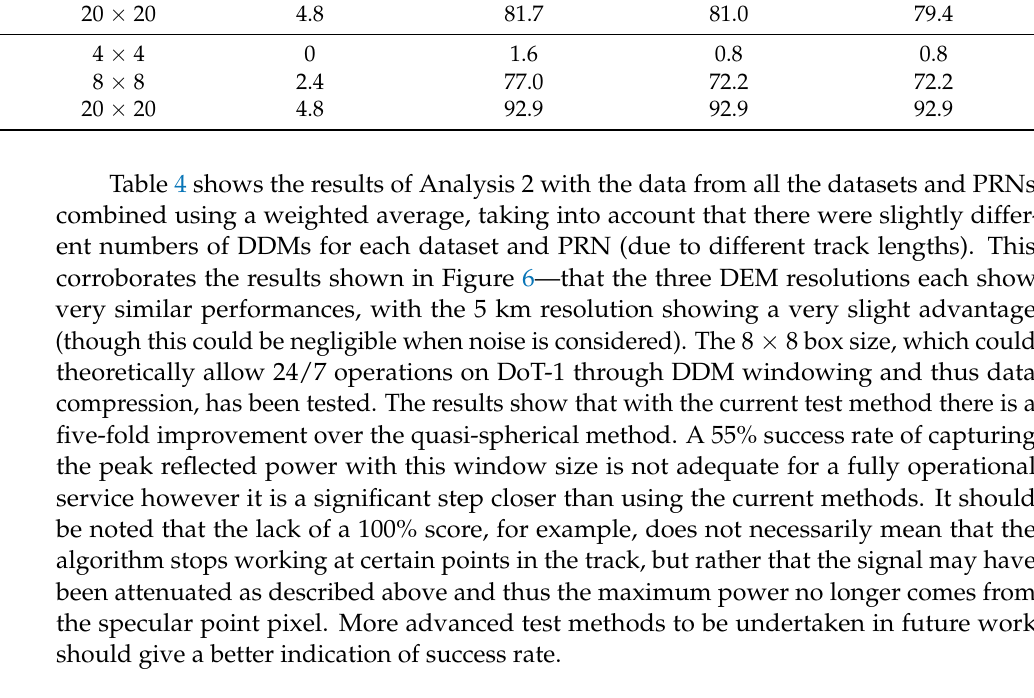
Table 4. Results of Analysis 2 on all datasets, combined as a weighted average using number of DDMs for each dataset and